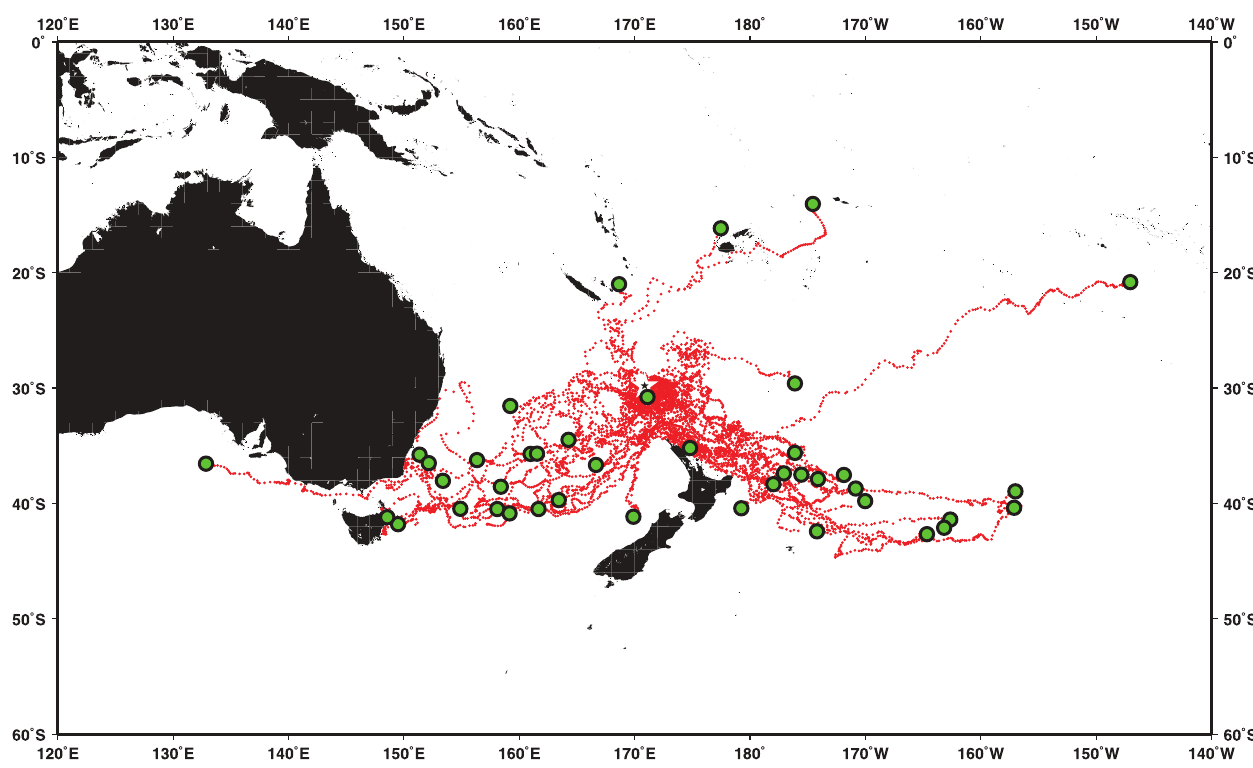
Figure 1. Satellite tag trajectories of 42 tagged oceanic juvenile loggerhead turtles. The single star denotes the release site for all 42 turtles, and the circles denote the final transmission site for each turtle.